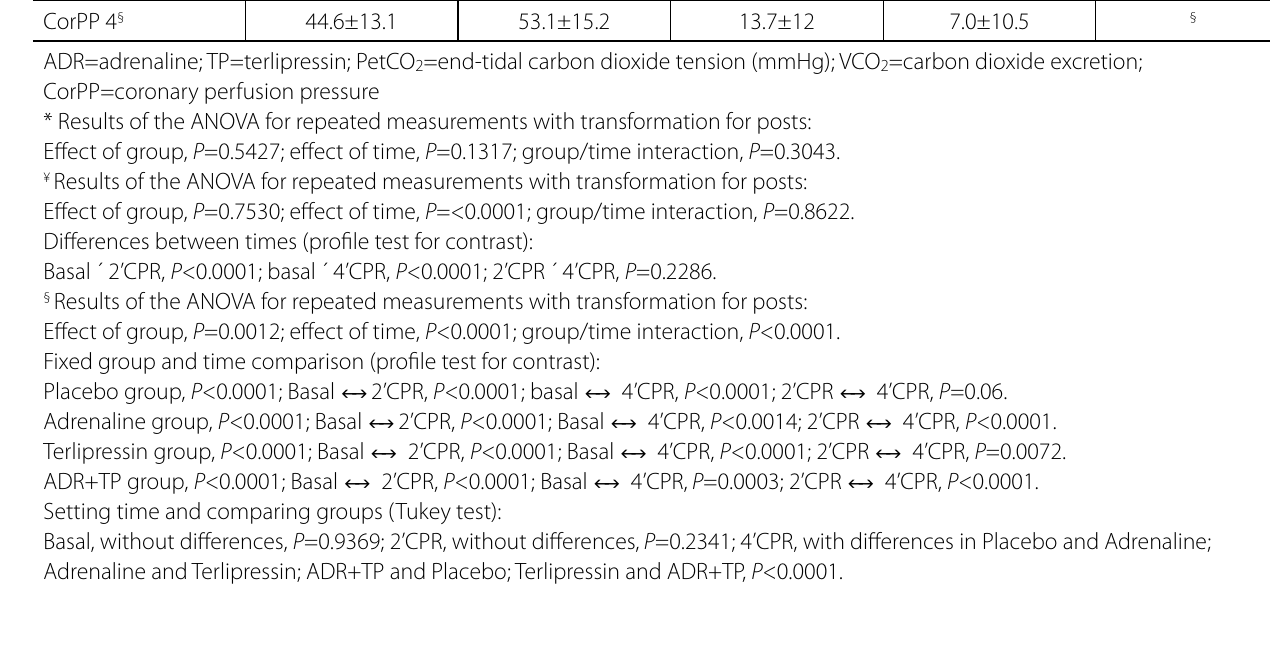
Table 2. Descriptive analysis and comparison of the percentage of survivors among the groups. Surviving